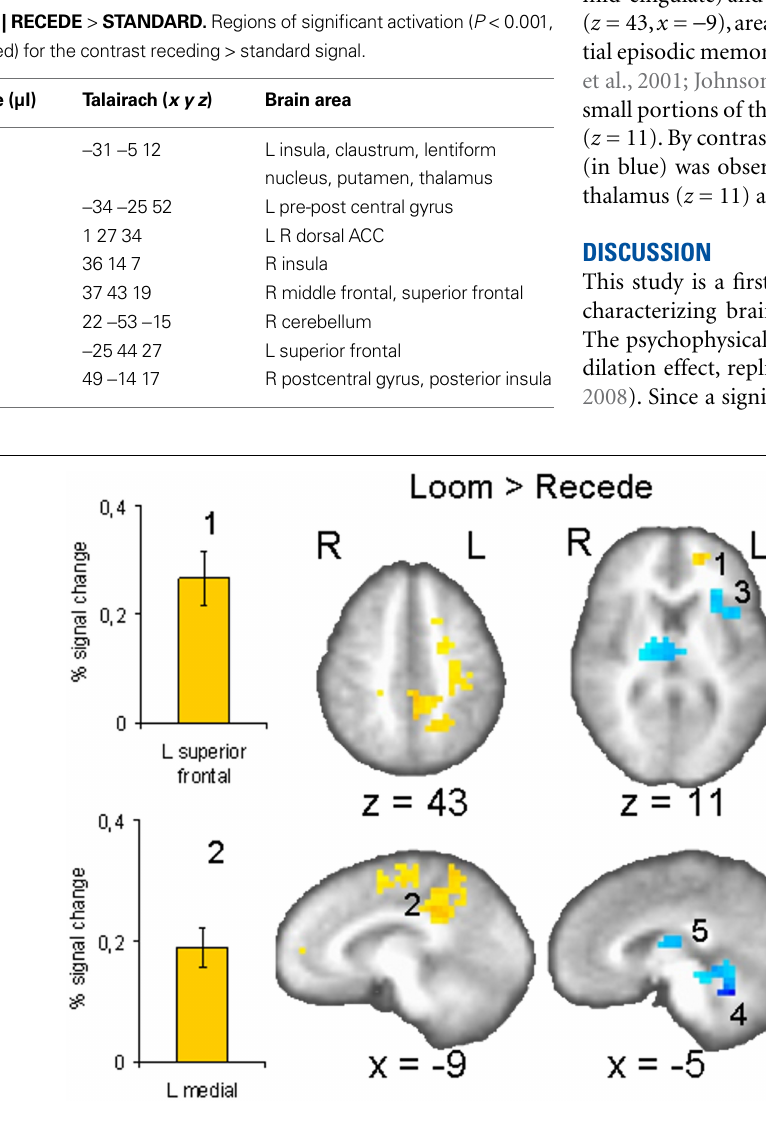
FIGURE 4 | fMRI: LOOM > RECEDE. Brain regions with signifi cantly greater activation for the LOOM > RECEDE (yellow to red voxels) and the RECEDE > LOOM (blue voxels) contrasts. Activation is depicted in axial (upper row) and sagittal views (lower rows); percent signal change is plotted (mean; SEM) as obtained through t -tests ( P < 0.05, corrected). Numbers in slices correspond to numbers in bar charts representing average percent signal change in specifi c regions of